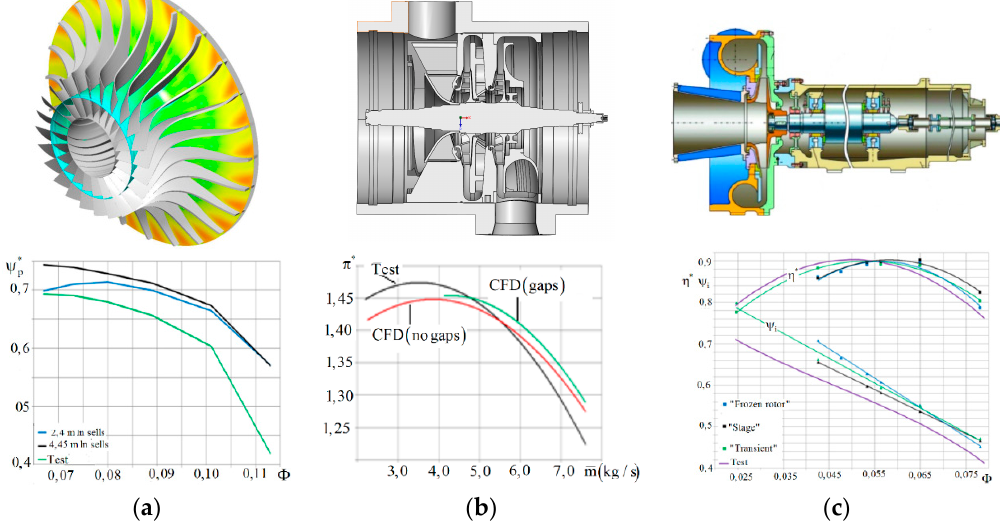
Figure 10. ( a ) The 3D impeller and its polytropic work coefficient characteristic [32]; ( b ) a two-stage pipeline compressor 16 MW and its pressure ratio characteristic [33]; ( c ) characteristics of the 1:2 model of a single-stage pipeline compressor of a 32 MW [34]. total pressures.